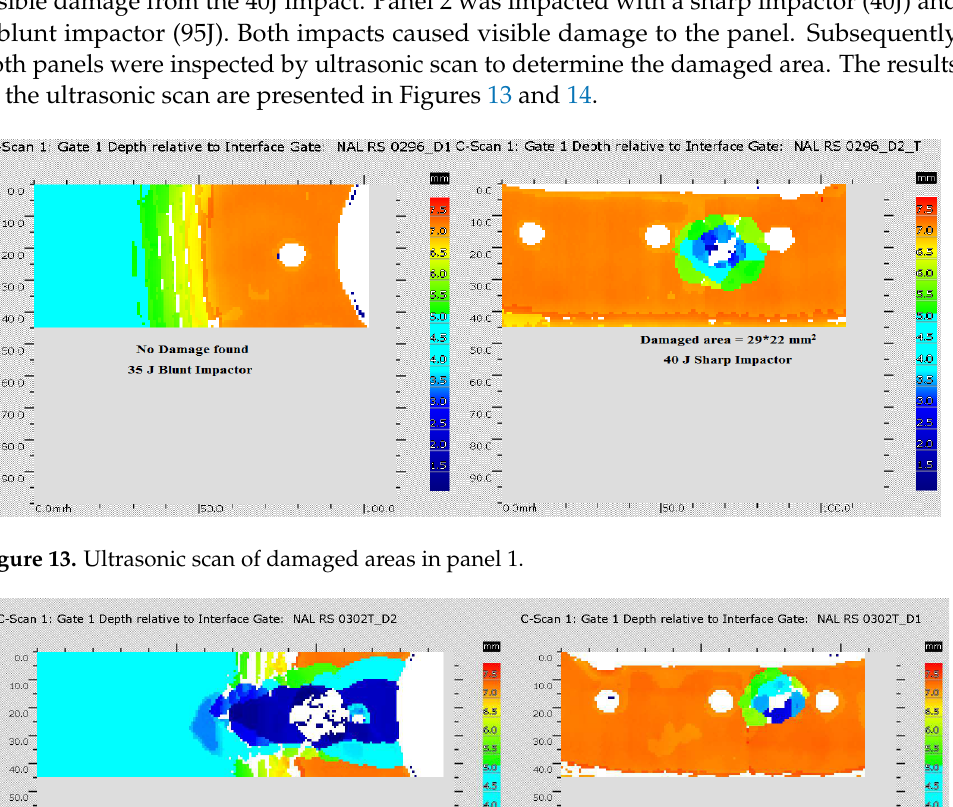
Figure 12. Impact damage on panel 2.